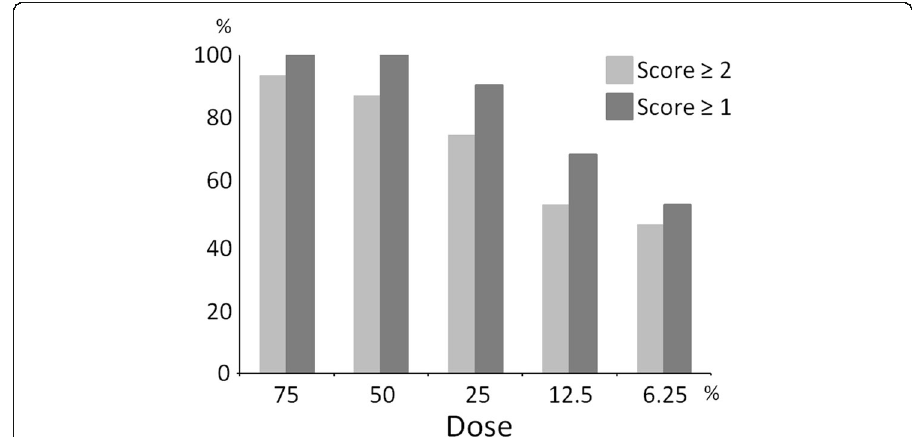
Fig. 4 Bar chart showing the percentage distribution of the image quality for dbPET images acquired at five reduced doses. Abbreviation: dbPET, dedicated breast positron emission tomography